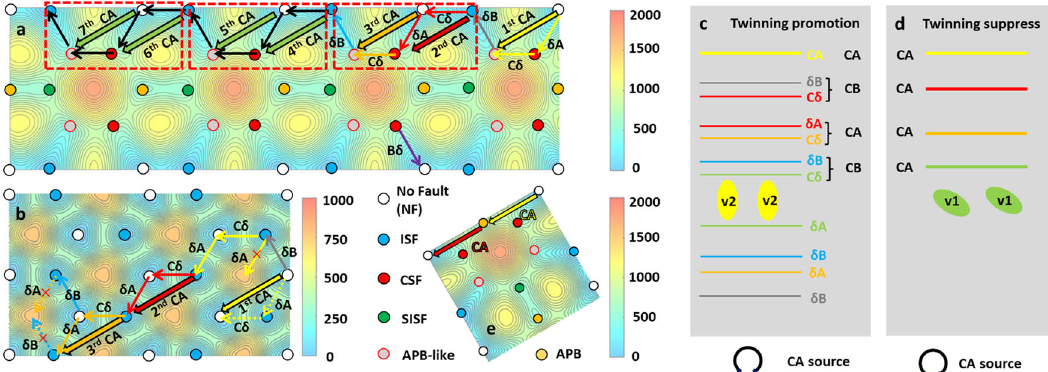
Fig. 3 Deformation pathways and dislocation content in the dislocation transformation process. Deformation pathways of a γ " and b γ phases shown in Fig. 2. c Summary of dislocations in Fig. 2. d Schematic precipitate microstructure suppressing twinning in γ ′′ -strengthened IN718 Ni-base superalloys. e The deformation pathway for the precipitate microstructure in d . The variant promoting twinning when CA dislocation is active is named v2 while the one suppressing twinning is named v1 to distinguish one from the other.